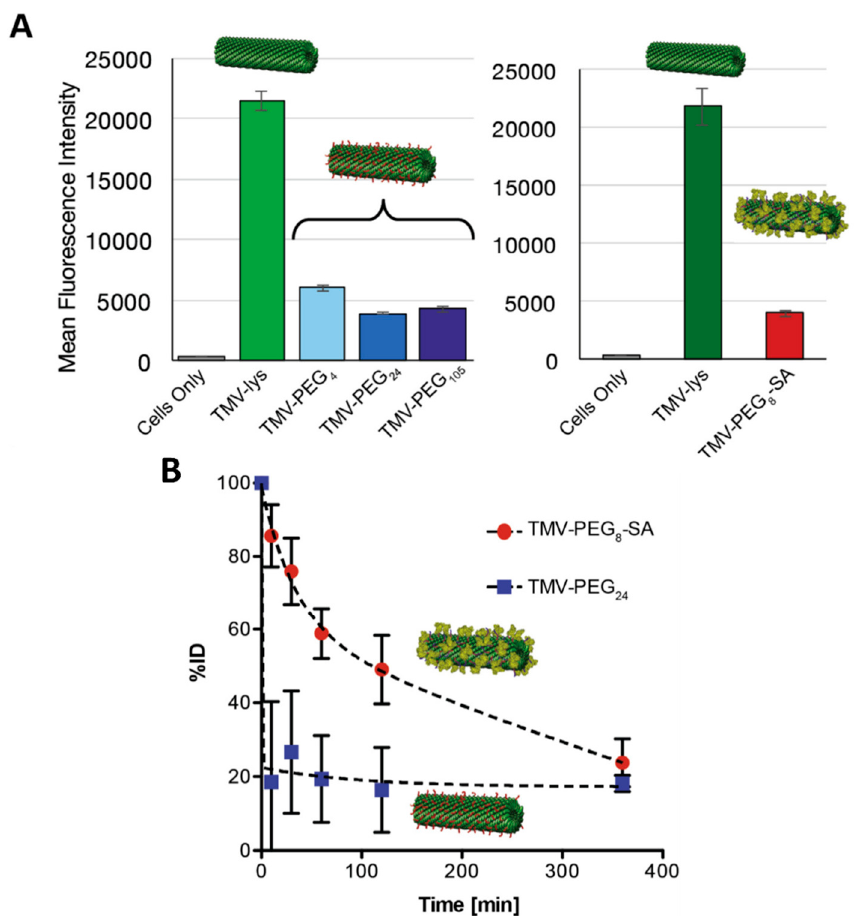
Figure 8 . ( A ) In vitro recognition of SA- and PEG-coated TMV vs. ‘naked’ TMV by RAW264.7 macrophages. Quantitative flow cytometry analysis of the interactions between ‘naked’ and ‘stealth’ TMV formulations and RAW264.7 cells. ( B ) Pharmacokinetics of the TMV-PEG24 and TMV-PEG8-SA particles in Balb/C mouse model. The particles were administered intravenously at the amount of 400 mg/mouse. Blood was collected before injection at t = 0 and after injection at t = 10 min, t = 30 min, t = 60 min, t = 120 min, and t = 360 min (the experiments were completed at an n = 3 per group) (Adapted with permission from [252], Copyright Elsevier,